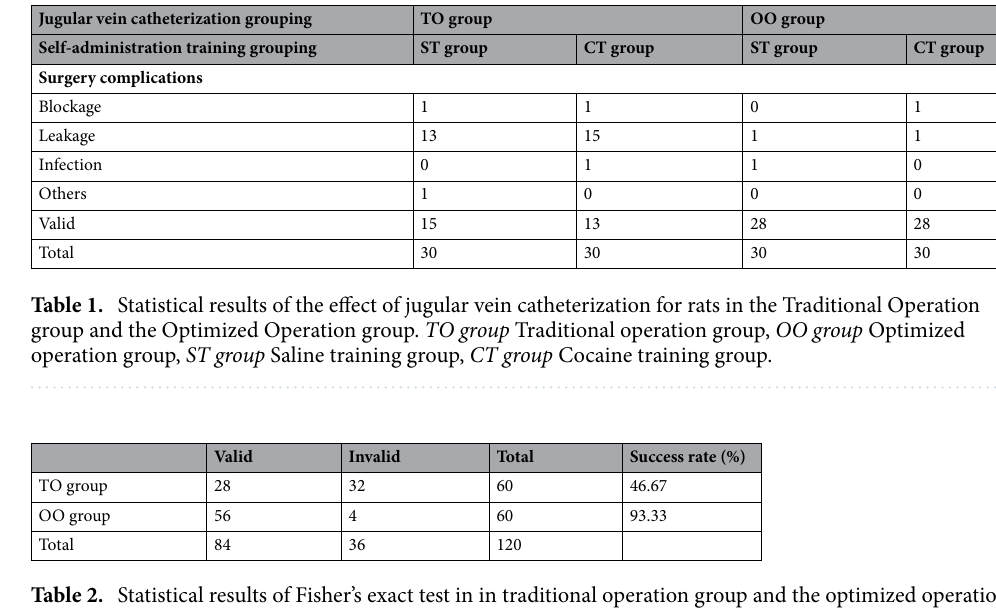
Table 2. Statistical results of Fisher’s exact test in in traditional operation group and the optimized operation group. TO group Traditional operation group, OO group Optimized operation group.